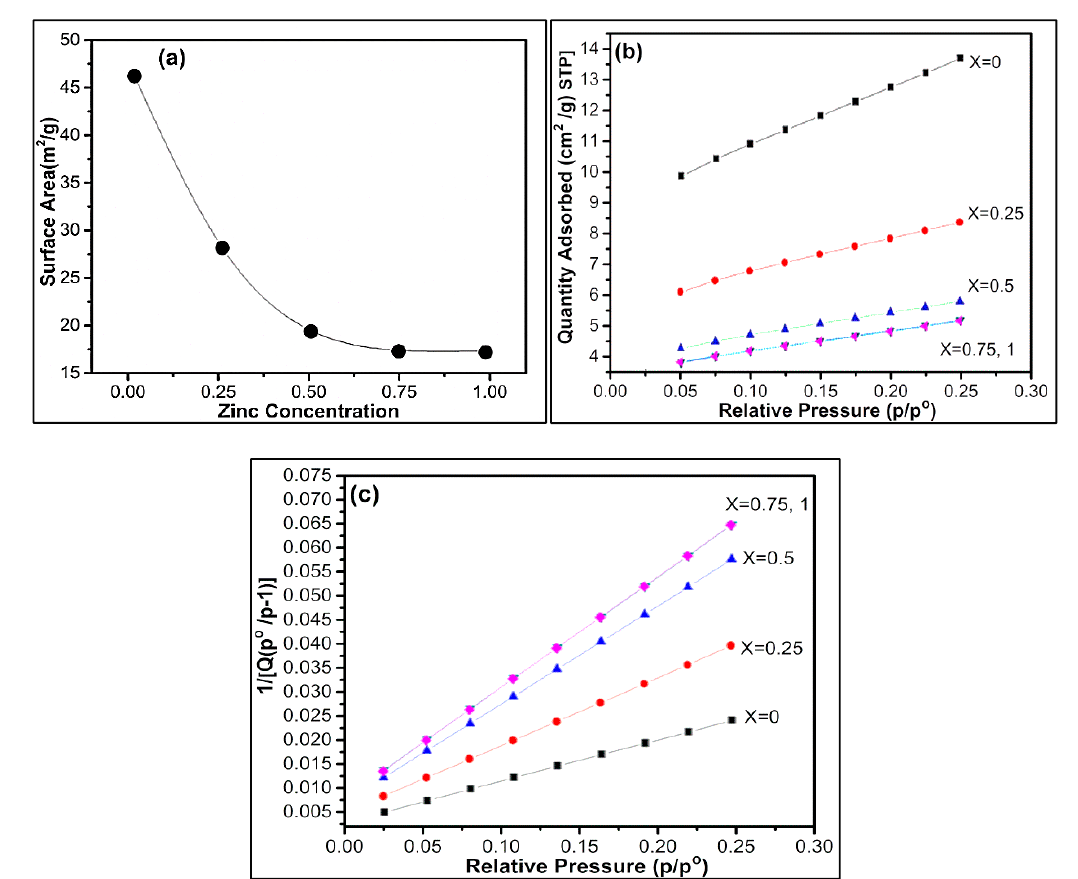
Figure 5. ( a ) A plot of the surface area versus zinc concentration. ( b ) The BET isotherm (linear plot) for Ni 1-x Zn x Fe 2 O 4 . ( c ) BET surface area plot for Ni 1-x Zn x Fe 2 O 4 . Table 3. The surface area analysis of nickel zinc nanoferrites.